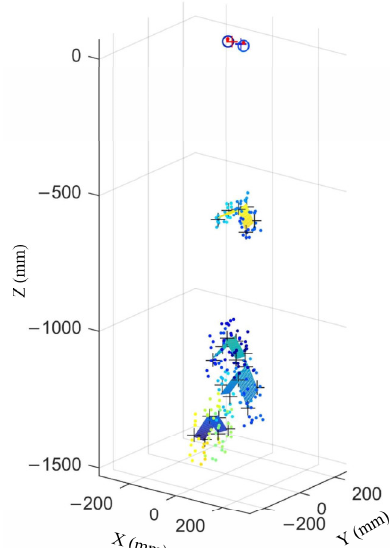
Figure 11. Placing a box in four different positions in front of the tester, and allowed this tester to watch the six visible corners of the box. The crosses in the graph represent the six visible corners of the box, and the colored grid planes show the two visible surfaces of the box. The scattered dots represent the location of the calculated points-of-regard by each fixation. This experiment shows that our method can calculate the 3D PoR coordinates when the system is used in a common scene.